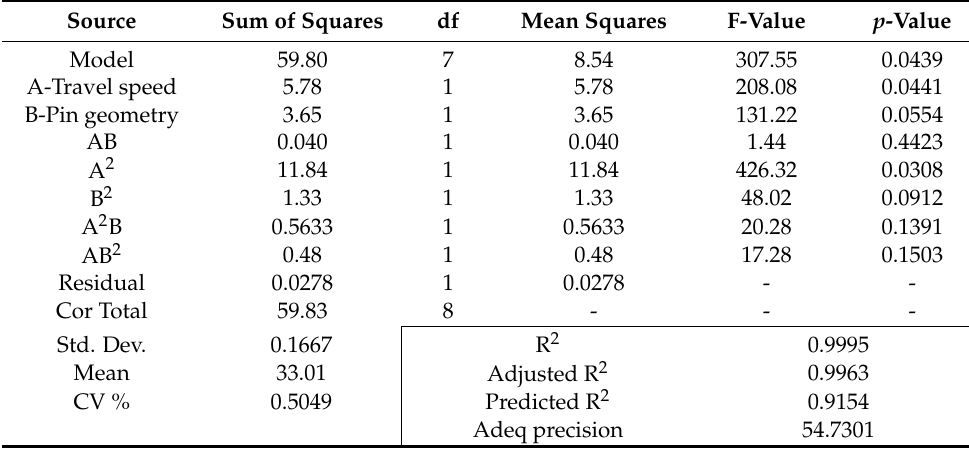
Table 7. ANOVA for the hardness values of AA1050 BT-FSP